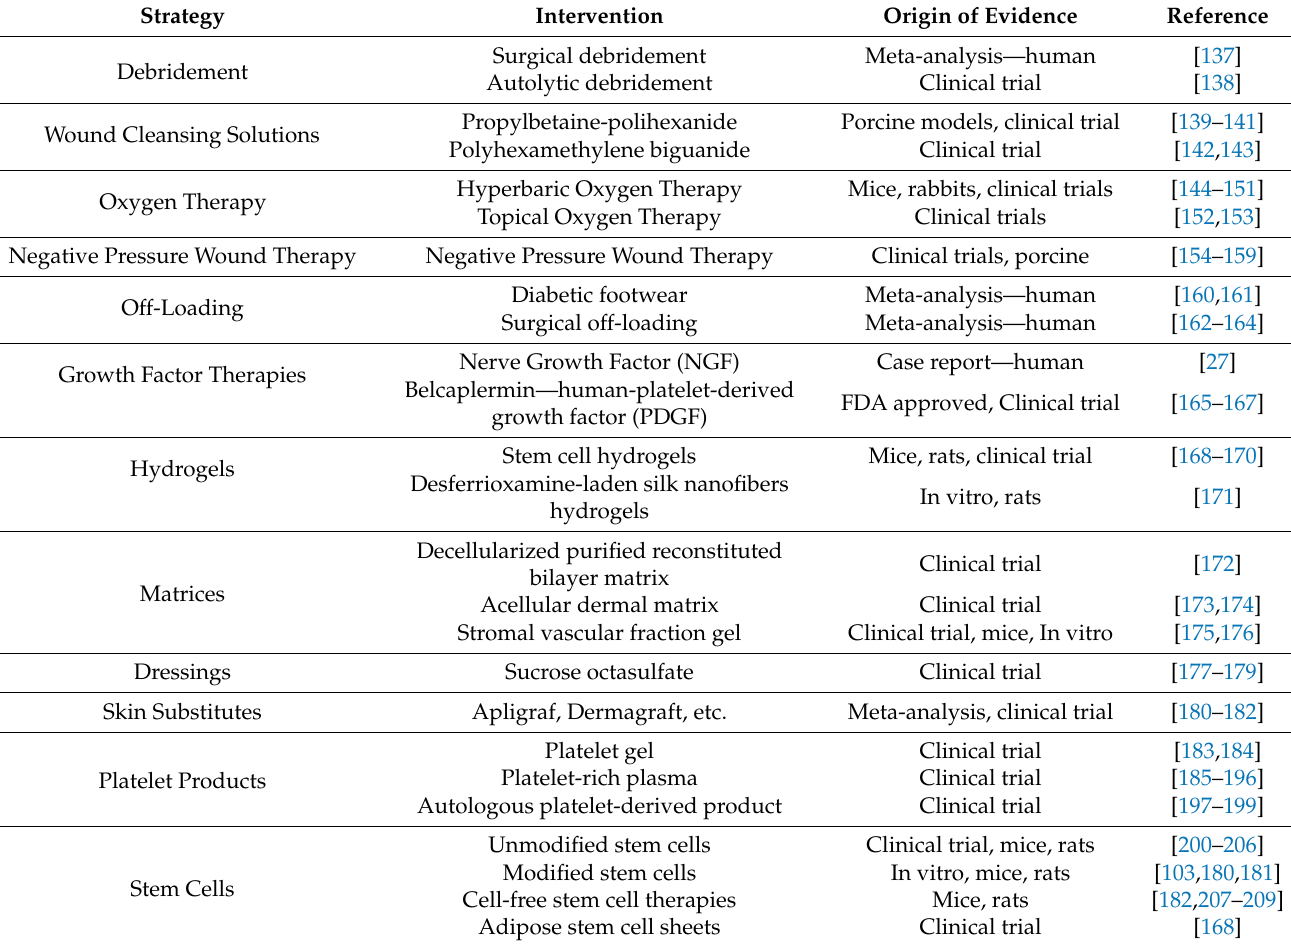
Table 1. Summary of current treatment strategies for diabetic